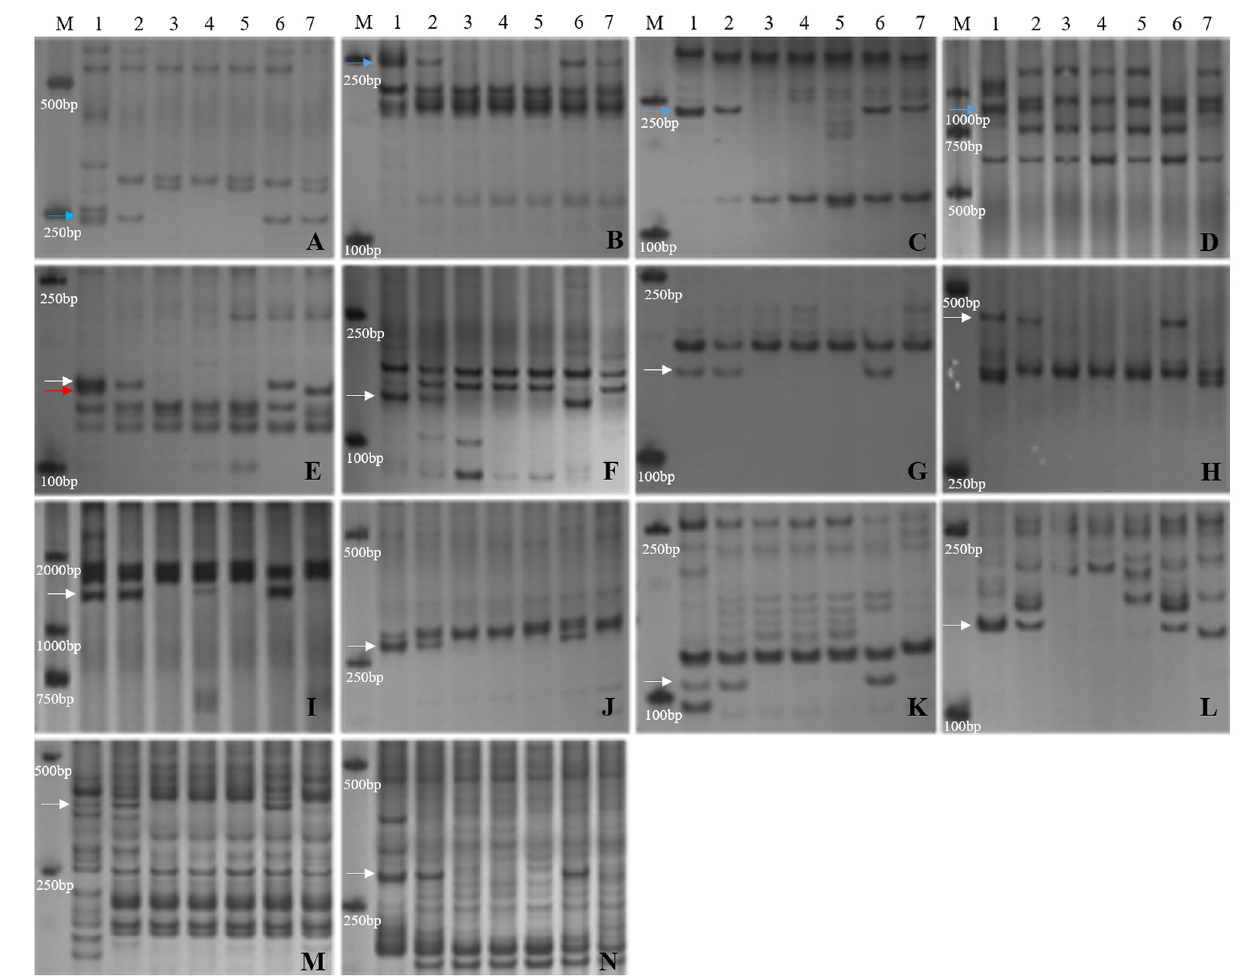
FIGURE 5 | Molecular marker analysis of SN19647 and CH10A5 (specific markers in SN19647). (A) CINAU857. (B) CINAU889. (C) CINAU886. (D) CINAU862. (E) CINAU880. (F) CINAU851. (G) CINAU859. (H) CINAU865. (I) CINAU870. (J) CINAU890. (K) SWES650. (L) Xgwm268. (M) BE405232. (N) Xmag3030. Lanes: M, DL2000; 1-7 refer to Th. ponticum , SNTE20, SNF63, YN15, JM22, SN19647 and CH10A5, respectively. The blue, red, and white arrows indicate the band shared between SN19647 and CH10A5, specific to CH10A5 and SN19647,